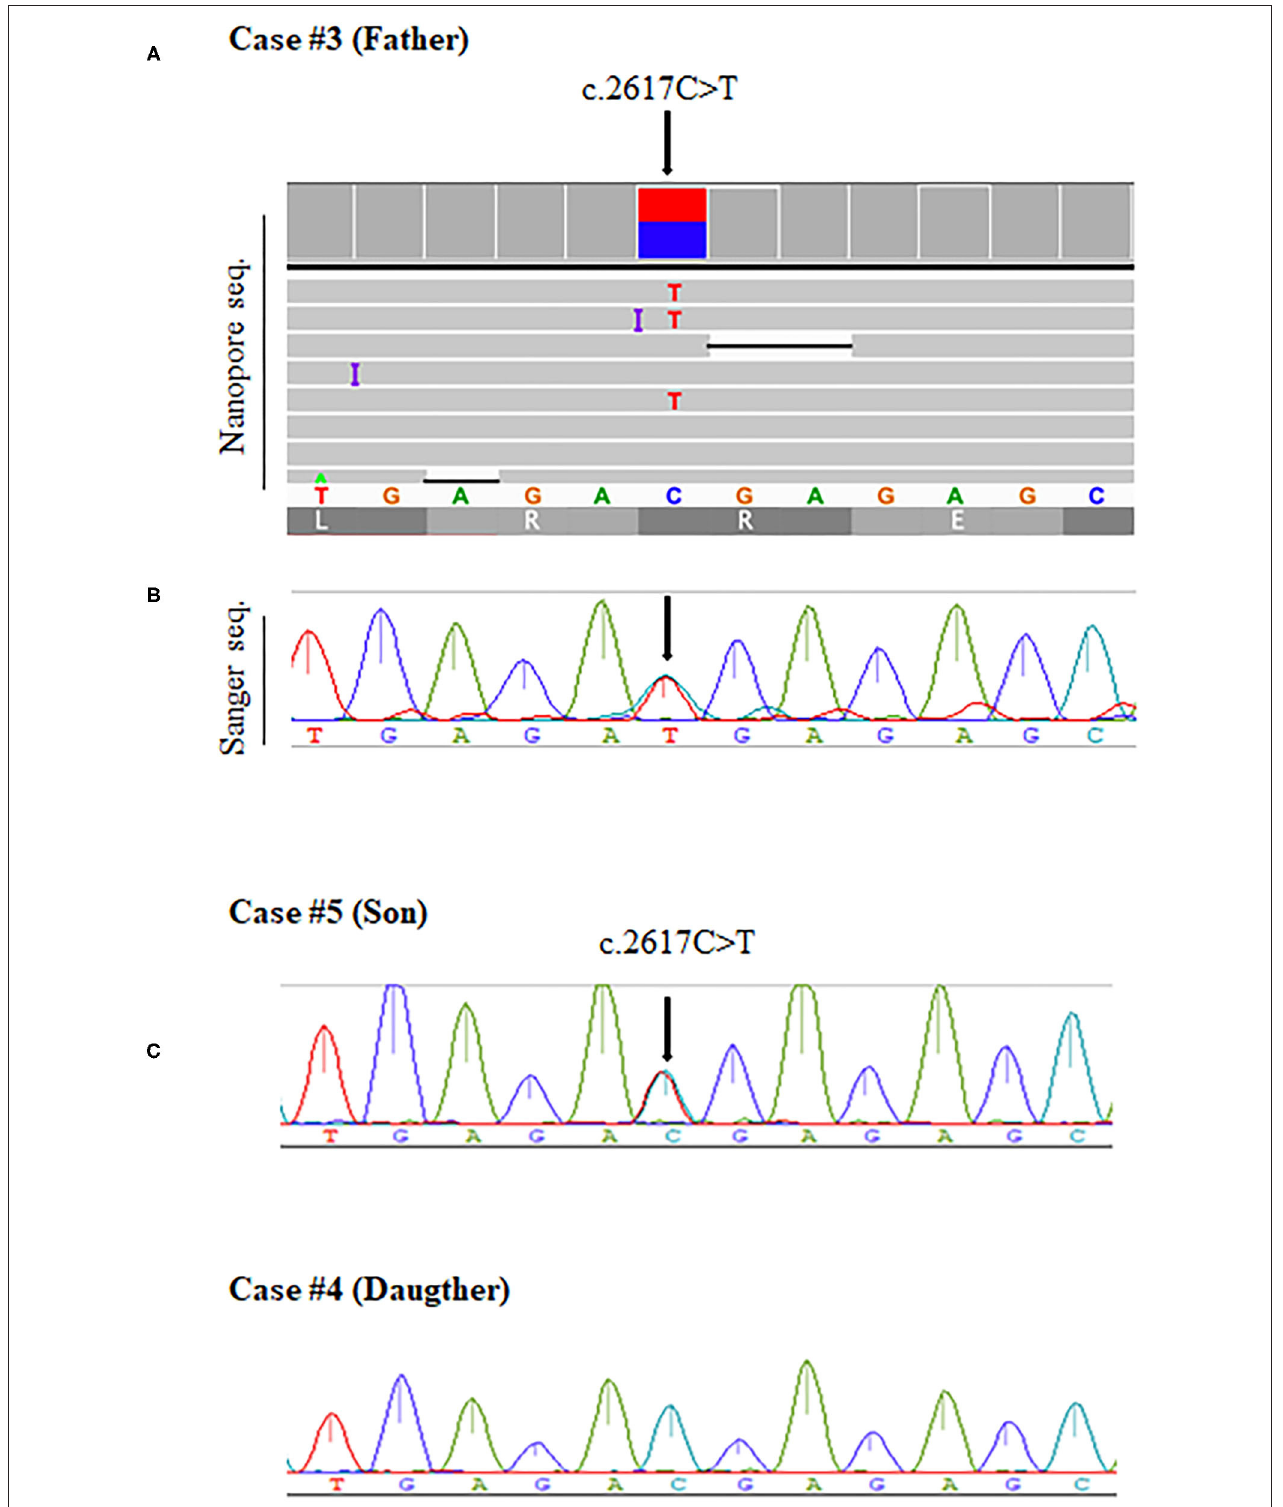
FIGURE 3 | The BMPR2 mutation c.2617C > T was detected in two members of a family (Cases #3 and #5) and validated by Sanger sequencing. Arrows indicate mutations in the heterozygous state. (A) Integrative genomics viewer (IGV) screenshot and Sanger validation of case #3 with PAH. (B) Sanger sequencing results show the same mutation being detected for case #5, the unaffected son. (C) Sanger sequencing results for case #4, the healthy daughter, show no mutations.